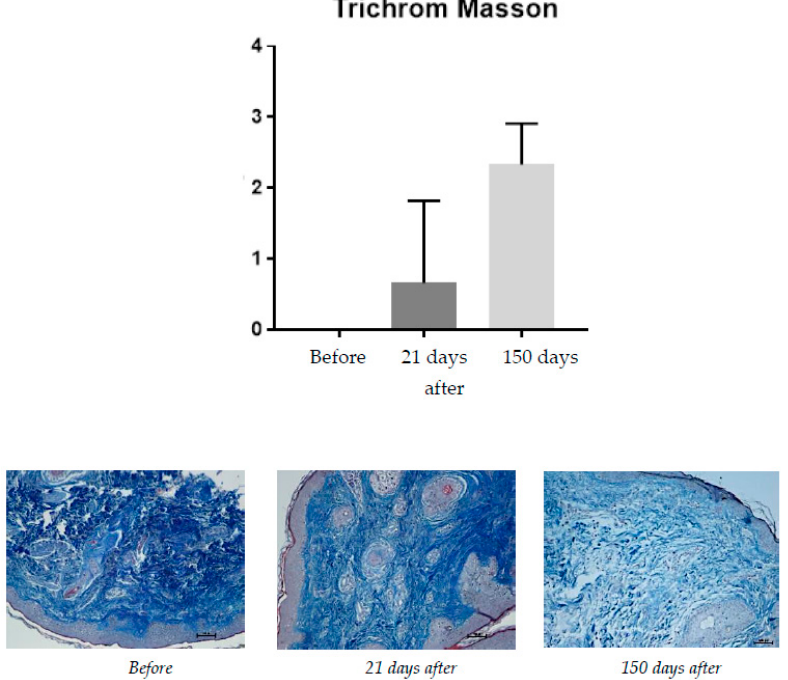
Figure 7. Patient, 61 years old. Masson’s trichrome staining, from left to right: before treatment; 21 days after treatment; 150 days after treatment. 2.2. Cutometric Results Cutometric measurements of skin elasticity and hydration were performed before treatment and at 5 months and 21 days after the treatment. For both elasticity and hydration, a scale of 0–100 (0—worst, 100—best) was used. • Skin elasticity: Change in skin elasticity (Figure 8).